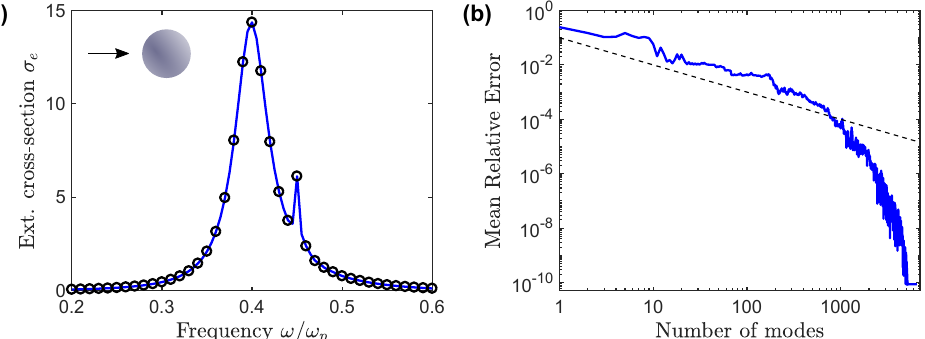
Figure 1. Complex QNM frequencies for a metallic sphere with a Drude permittivity. ( a ) Full eigenvalues spectrum computed with the QNM solver. Red squares show the two QNMs responsible for the resonances observed in the spectral range of interest. ( b ) Eigenvalues forming an accumulation point at the pole ω = − i γ of the permittivity. ( c ) Cloud of eigenvalues close to the origin that correspond to static modes.